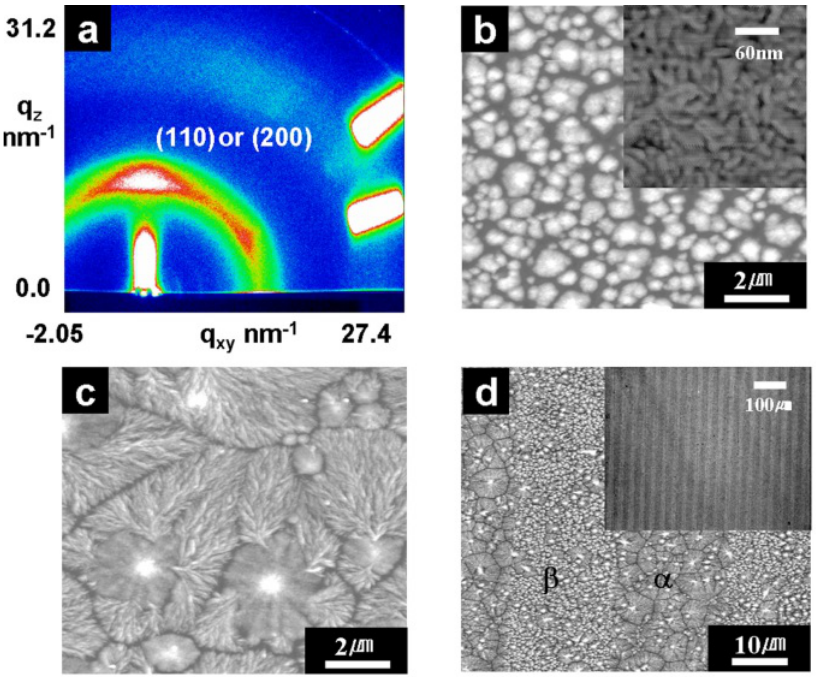
Figure 7. ( a ) 2D GIXD pattern and ( b ) AFM image of PVDF film with a 200 nm thick fabricated by spin coating on Au substrate and rapidly annealed at 150 °C; ( c ) AFM images of a PVDF film spin coating on treated Au substrate and rapidly annealed; ( d ) AFM image of α and β phase PVDF crystals [8].